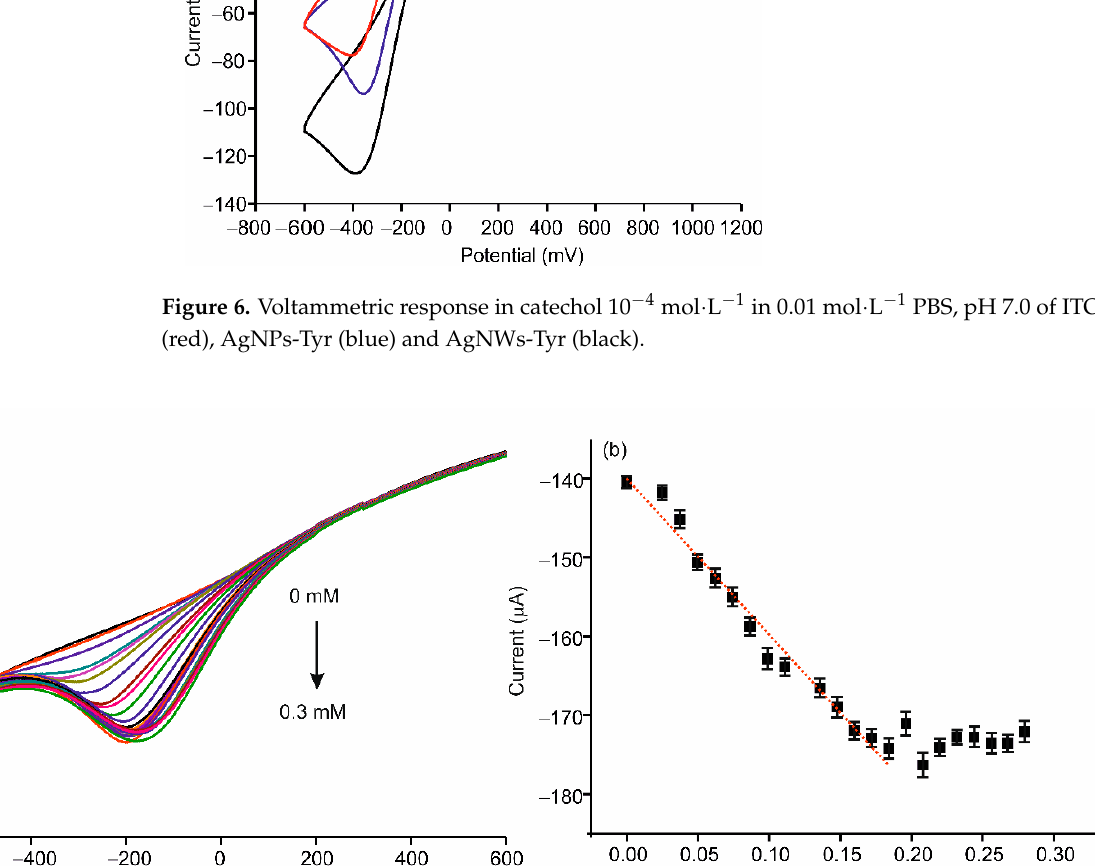
Figure 6. Voltammetric response in catechol 10 − 4 mol·L − 1 in 0.01 mol·L − 1 PBS, pH 7.0 of ITO-Tyr (red), AgNPs-Tyr (blue) and AgNWs-Tyr (black).